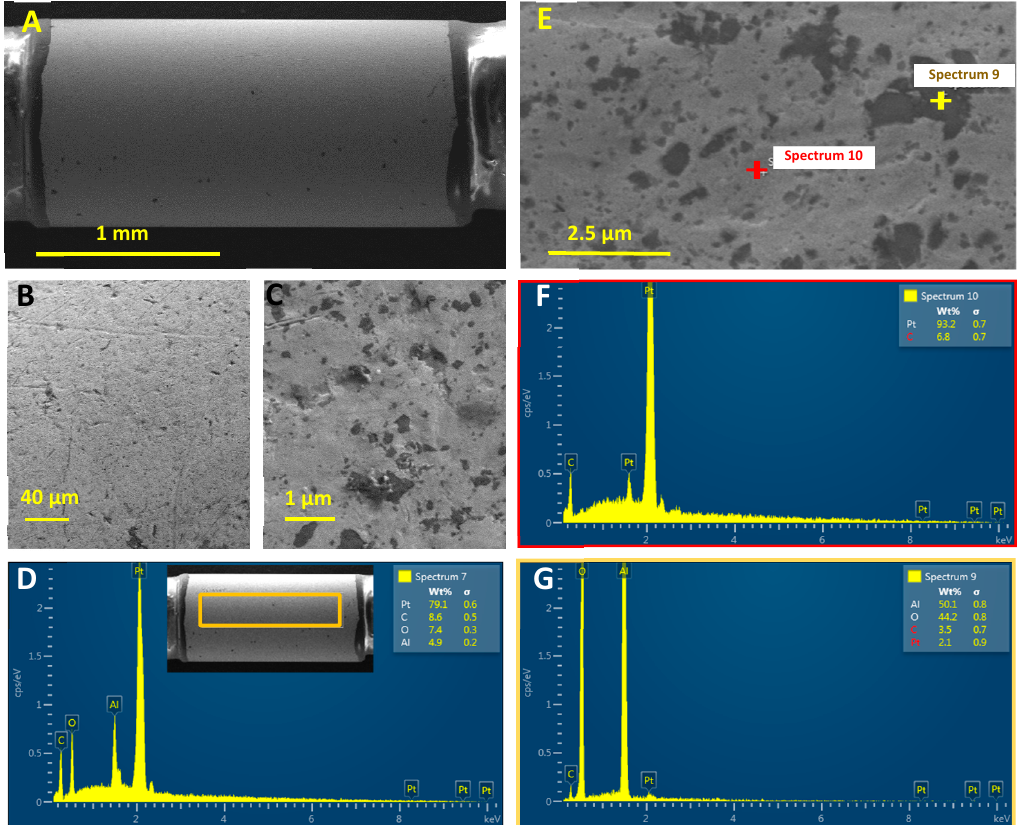
Figure 1. ( A ) General view of a recording site on the Auragen TM Probe; ( B ) and ( C ) High ‐ resolution micrographs of the recording surface; ( D ) EDS elemental analysis of the surface (ROI indicated in inset with orange rectangle); ( E ) Different regions of the recording surface were targeted for EDS elemental analysis, indicated with red and yellow “+” signs, respectively; ( F ) and ( G ) show the elemental composition spectrum of the lighter (conductive) regions (predominantly Pt) and of the darker (non ‐ conductive) region (predominantly Al and O), respectively.